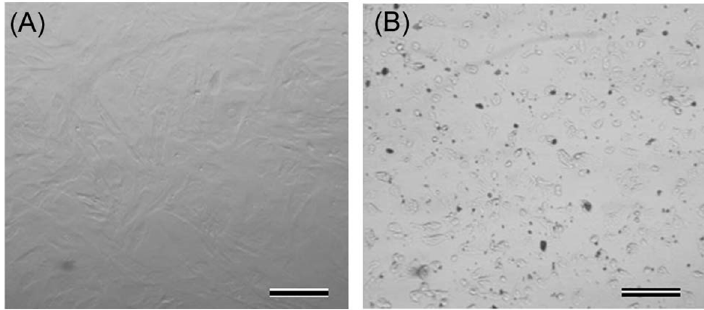
Figure 1. Representative phase contrast microscopy images demonstrating control ( A ) and 100 μ g/mL zinc oxide-treated cells ( B ). Scale bars: 100 μ